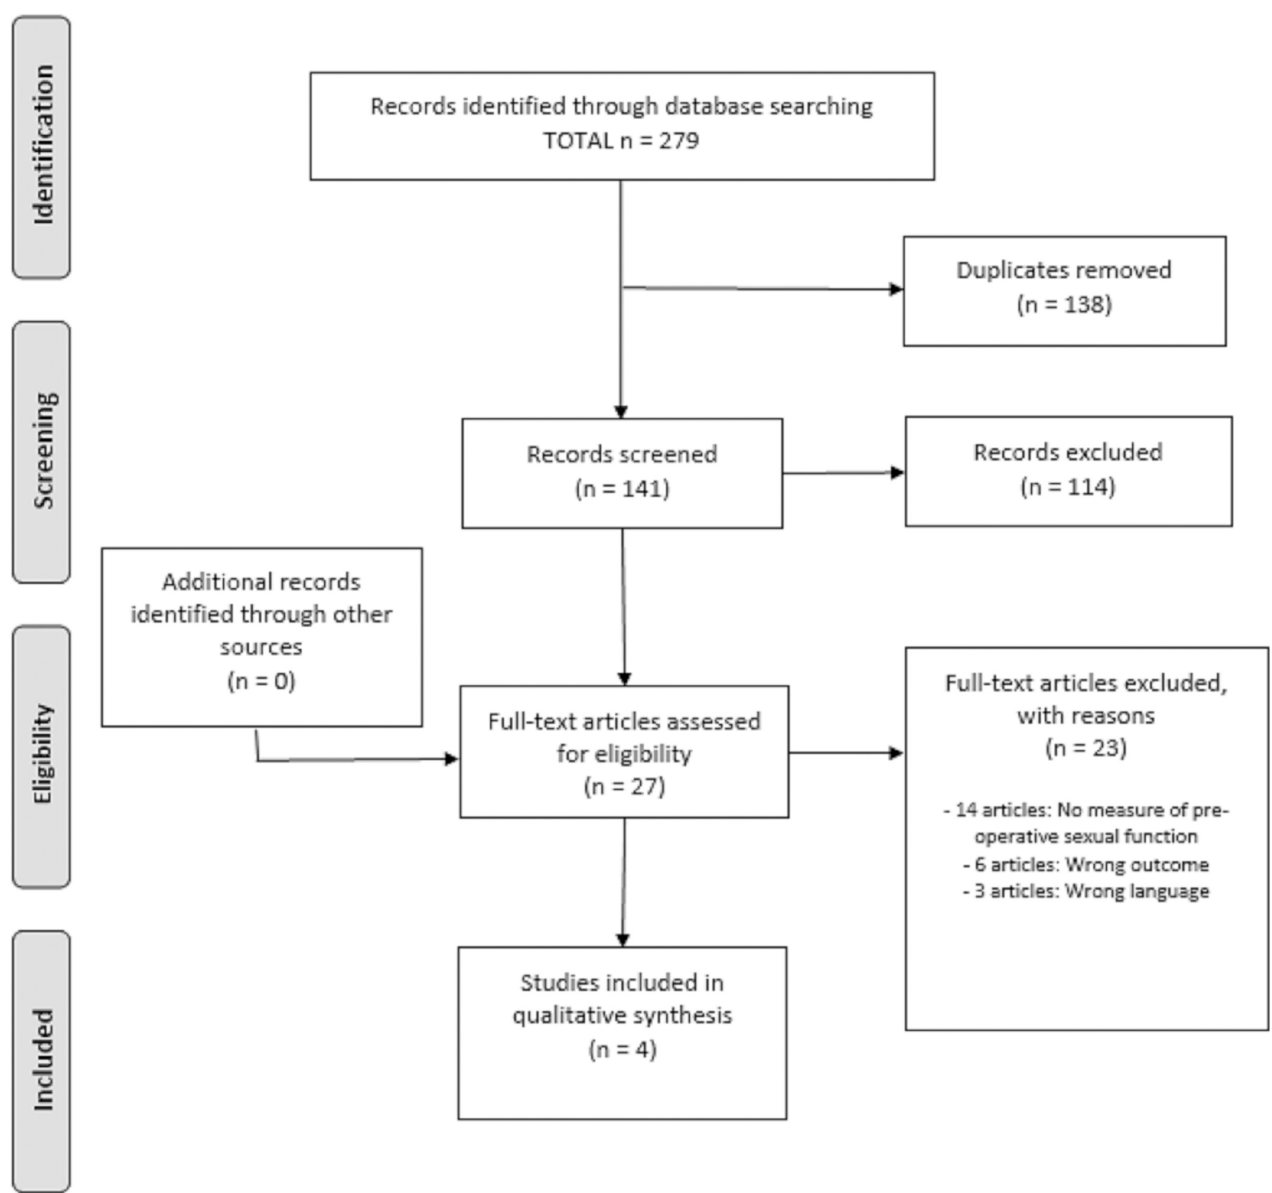
Fig 1. PRISMA flow chart of the study selection